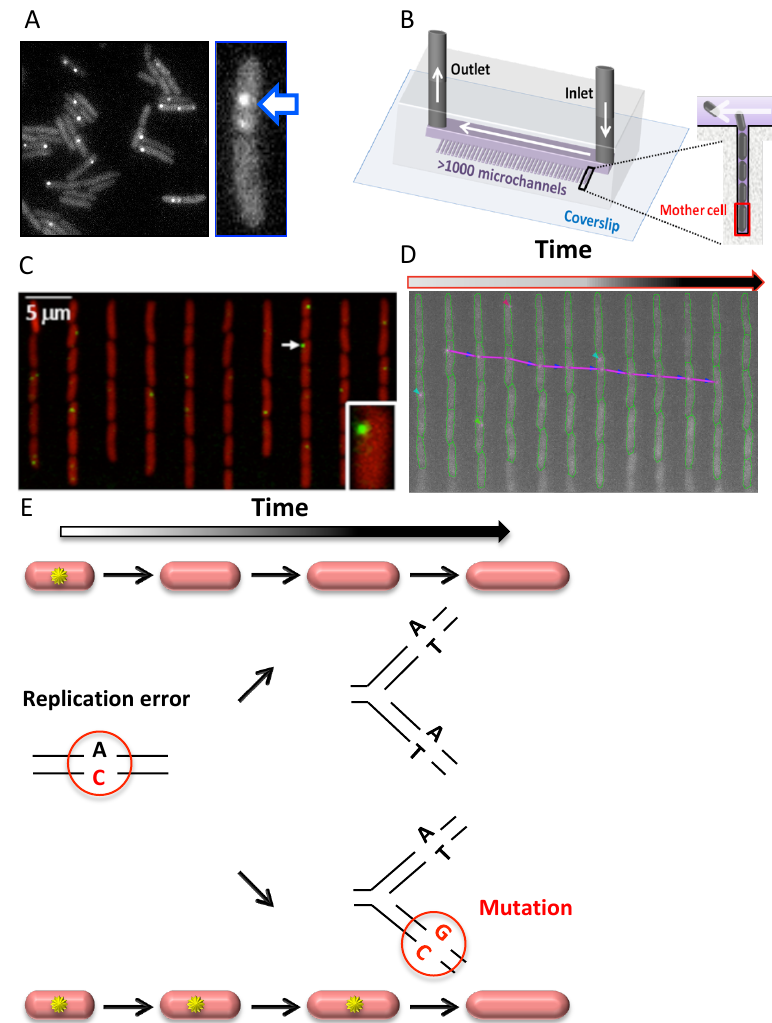
Figure 2. Visualization of MutL in single cells allows detection of replication errors and nascent mutations. ( A ) MMR MutL protein tagged with a yellow fluorescent protein (YFP) accumulates on DNA around replication errors, creating a fluorescent focus (arrow). ( B ) The microfluidic device mother machine enables tracking the accumulation of fluorescent foci of MutL in single cells under controlled conditions over more than 100 cell divisions. ( C ) Representative image of a mother machine experiment showing growing E. coli cells expressing YFP–MutL and tdCherry. Overlay of red and yellow fluorescence images is shown. Inset: magnified image of a cell with a YFP–MutL focus. ( D ) Kymograph of a single microchannel over time, imaged in yellow fluorescence. The time interval between two successive images is 2 min. YFP–MutL foci are segmented (magenta contours) and tracked (colored arrows). Long- and short-lived foci are visible. Cell contours are in green. ( E ) Schematic representation of the fate of the different categories of MutL foci. When replication errors are repaired, the focus (yellow star) is short-lived, visible in cells (red cylinders) for <4 min. When they are not repaired, the focus has a long lifetime and lasts until a new DNA replication cycle fixes the mutation on one of the two DNA molecules (23 min on average under rich growth conditions). Adapted from Reference